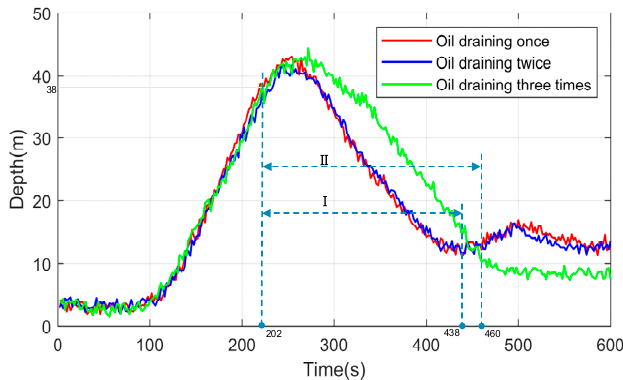
Figure 14. Depth variation during the experiment.